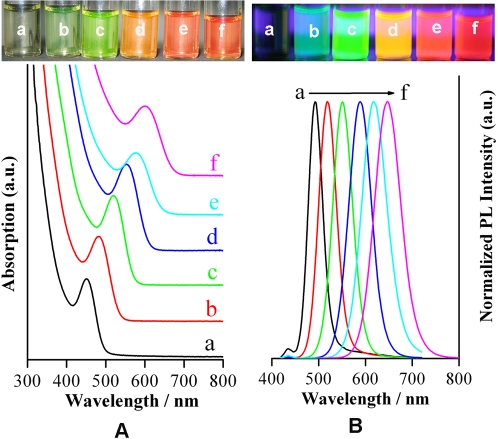
(A) The image of MSA-coated CdTe QDs with different sizes under ambient conditions (top) and the corresponding absorption spectra (bottom); (B) The image of the above-mentioned MSA-coated CdTe QDs under an ultraviolet lamp (top) and the corresponding photoluminescence spectra (bottom). The photoluminescence were at a) 493 nm, b) 519 nm, c) 551 nm, d) 589 nm, e) 617 nm, f) 647 nm. These CdTe QDs were synthesized at pH = 7.2.